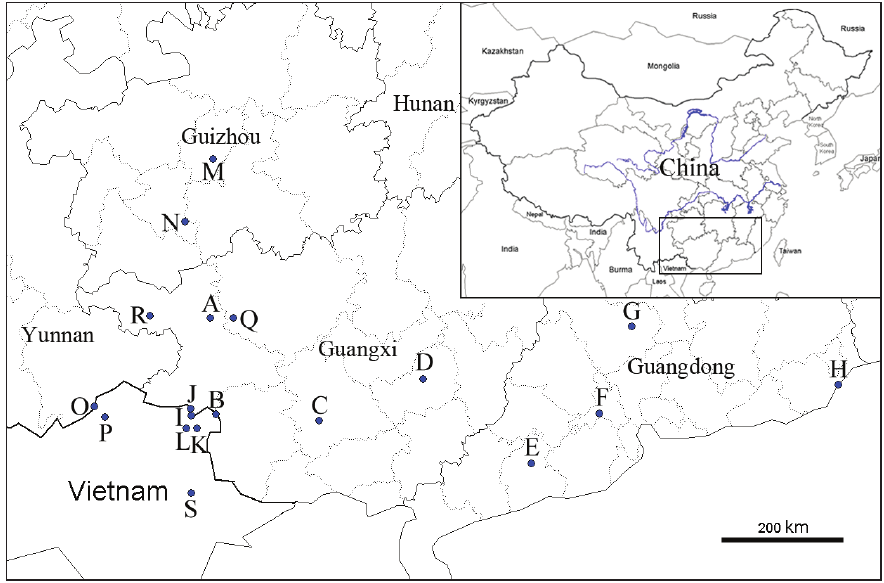
Figure 1. Map of locations of Camaena species. C. lingyunensis sp. n.: A Kasuo, Lingyun, Guangxi, China. C. detianensis sp. n.: B Detian Falls, Daxin, Guangxi, China. C. cicatricosa : C Nanning,